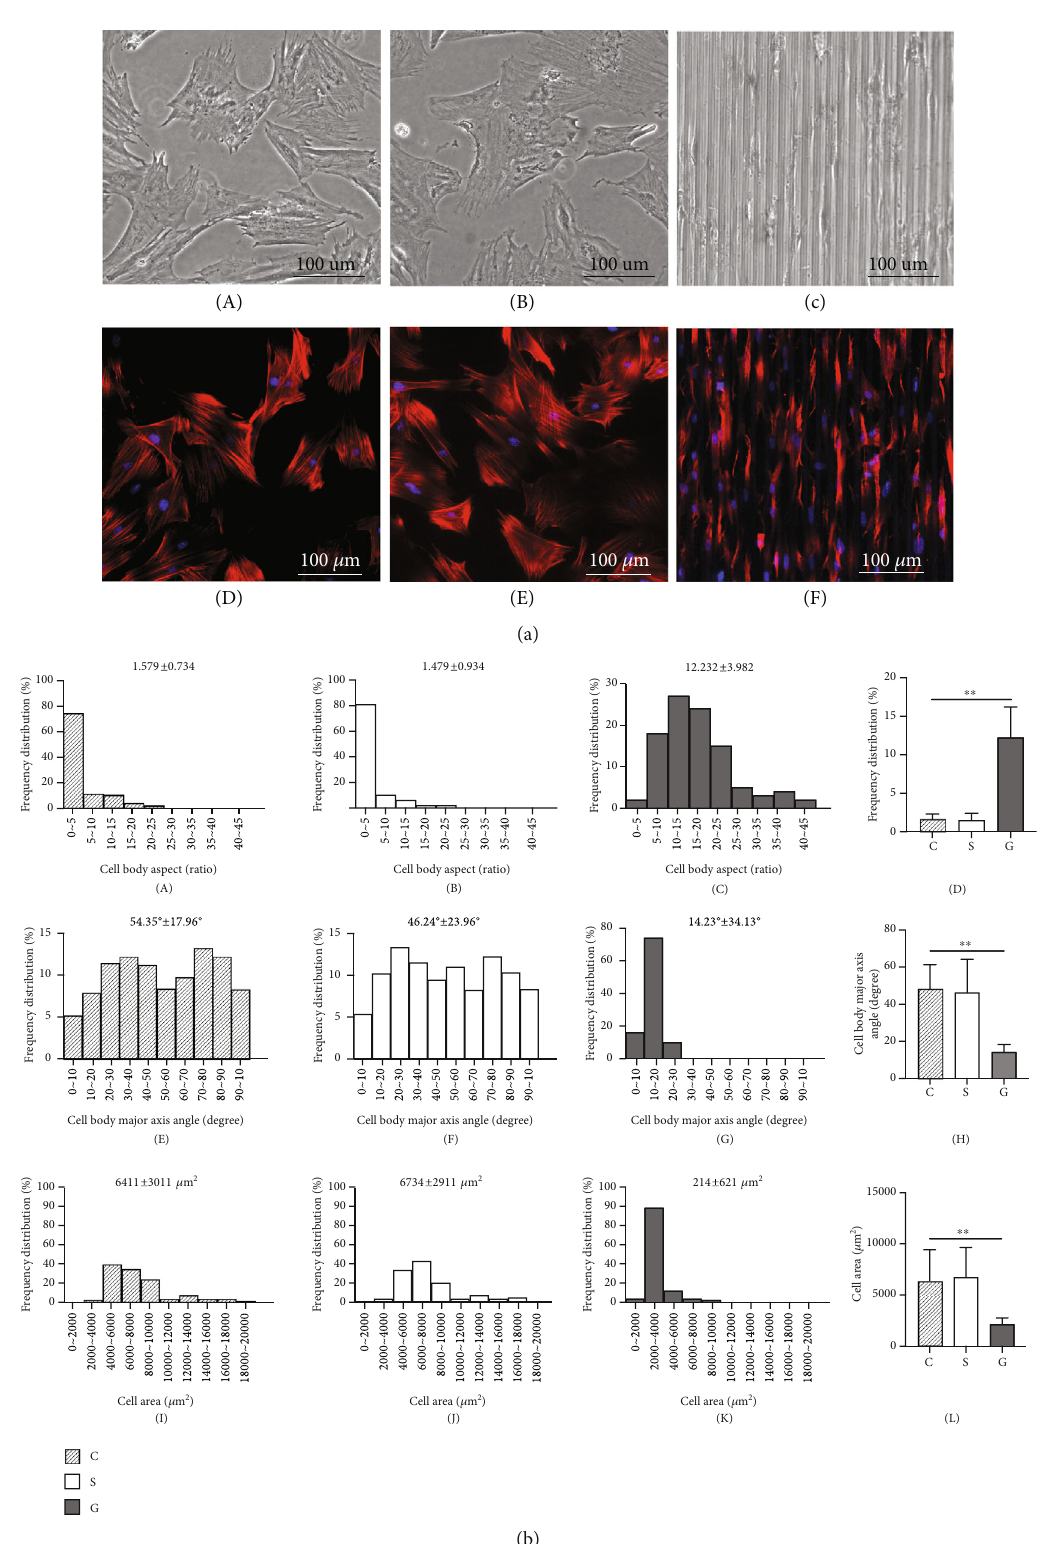
Figure 3: The cell morphology of TSPCs on di ff erent matrix surfaces. (a) Cell morphology observation: (A – C) cell morphology under a light microscope; (D – F) the morphology of TSPCs under a confocal laser scanning microscope. The nuclei were stained blue; the cytoskeletons were stained red; (A, D) TSPCs in the cell culture plate; (B, E) TSPCs on the smooth SF fi lm; (C, F) TSPCs on the SF fi lm with a microstructure. (b) Analysis of cell morphology: (A – D) cell body aspects; (E – H) cell body major axis angle (I – L) cell area; group C: TSPCs on the cell culture plate; group S: TSPCs on the smooth SF fi lm; group G: TSPCs on the SF fi lm with a microstructure; ∗∗ P < 0 : 01